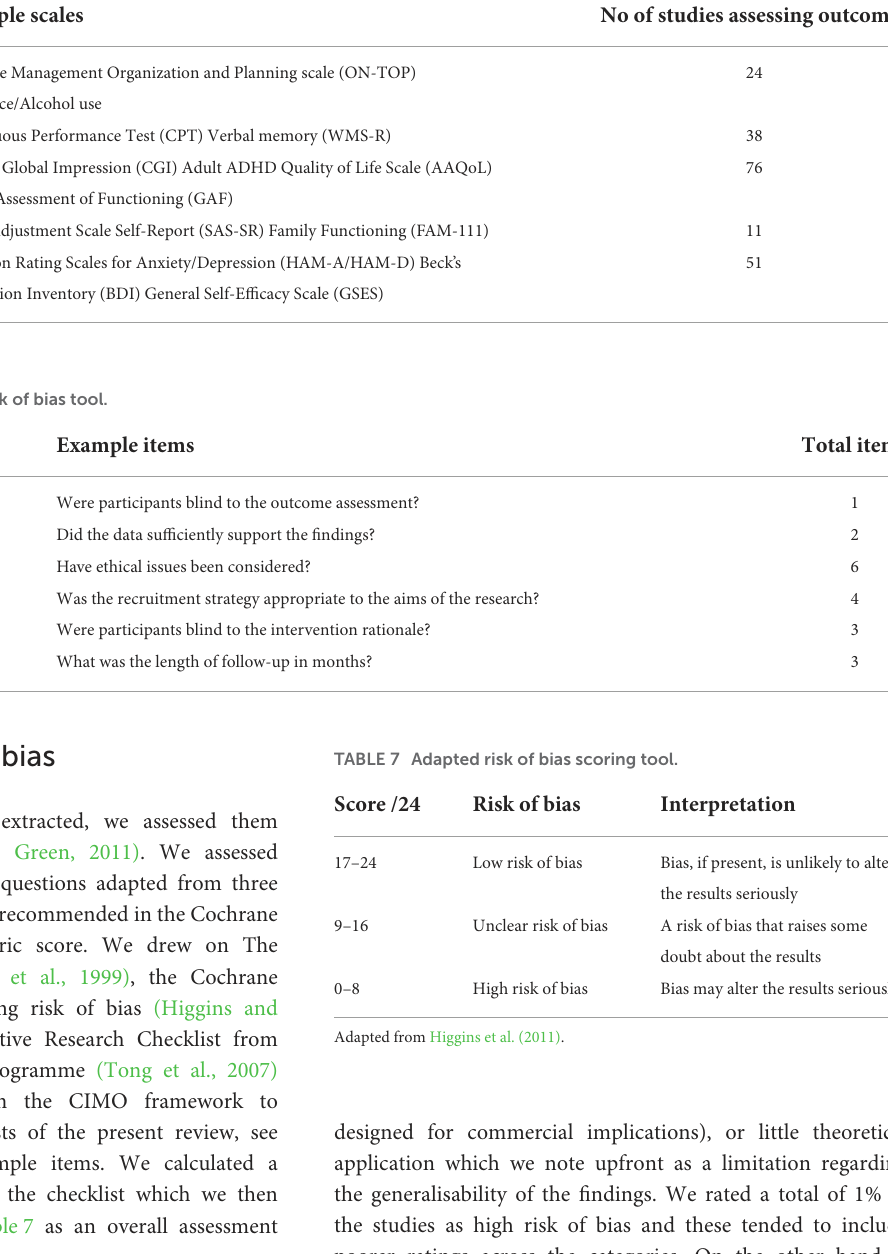
TABLE 5 Outcomes by category with examples and total number of studies assessing them.